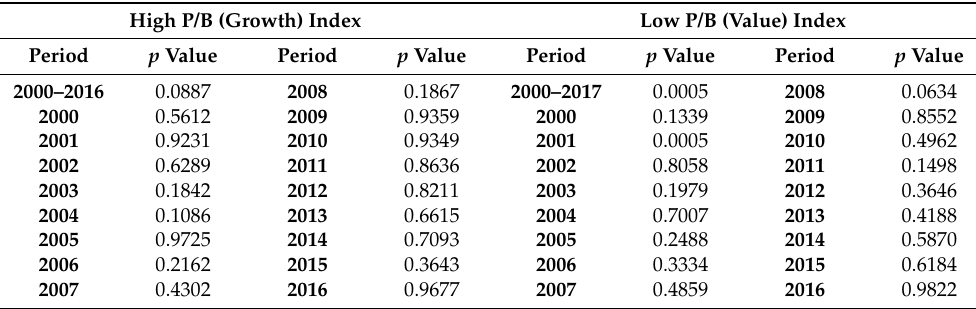
Table 11. Anderson–Darling test results ( p values)—P/B indexes.